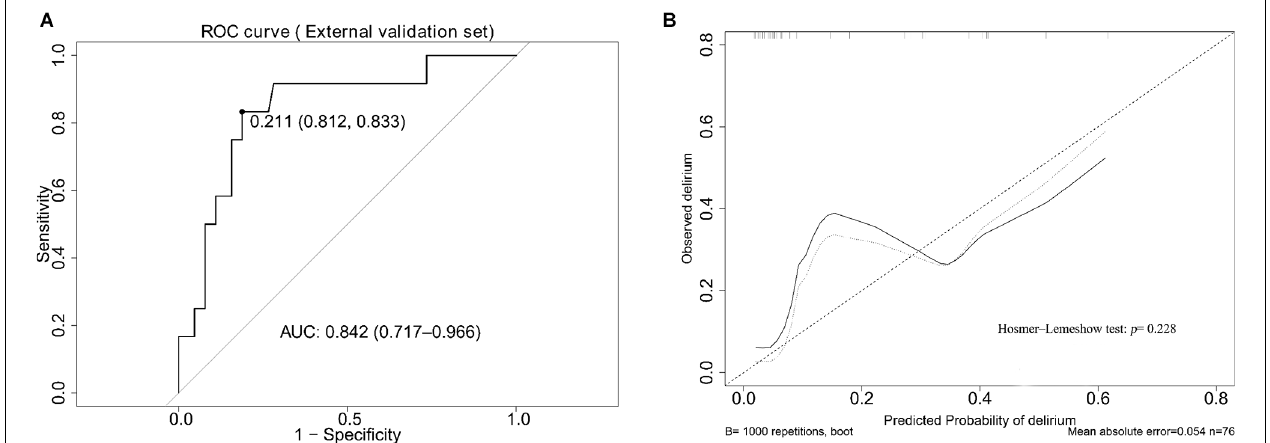
FIGURE 5 | The results of the ROC curve and calibration analysis of the nomogram in the external validation set. (A) The AUC of the nomogram for predicting POD in the external validation set. (B) The calibration curve of the nomogram in the external validation